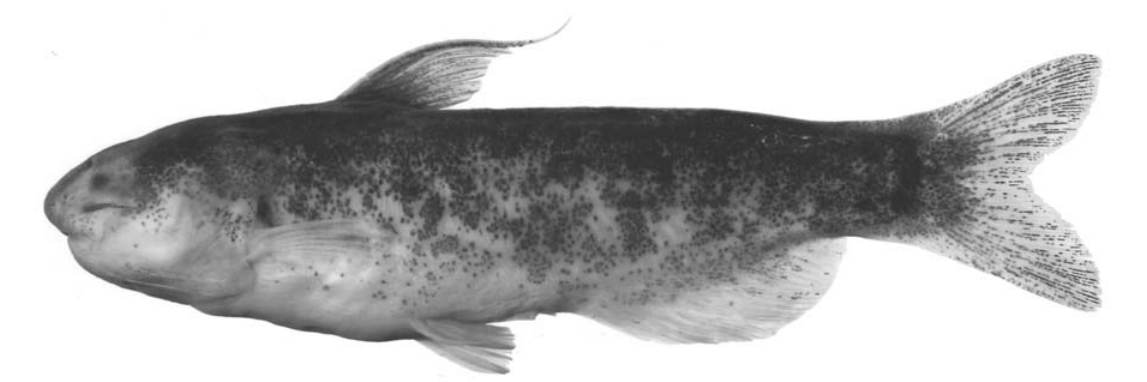
Fig. 39. Cetopsis sandrae , new species, holotype, male, MZUSP 61091, 64 mm SL; Brazil, Mato Grosso, Nova Mutum, unnamed Córrego, Fazenda Buriti (13°51’52"S, 56°11’36"W).